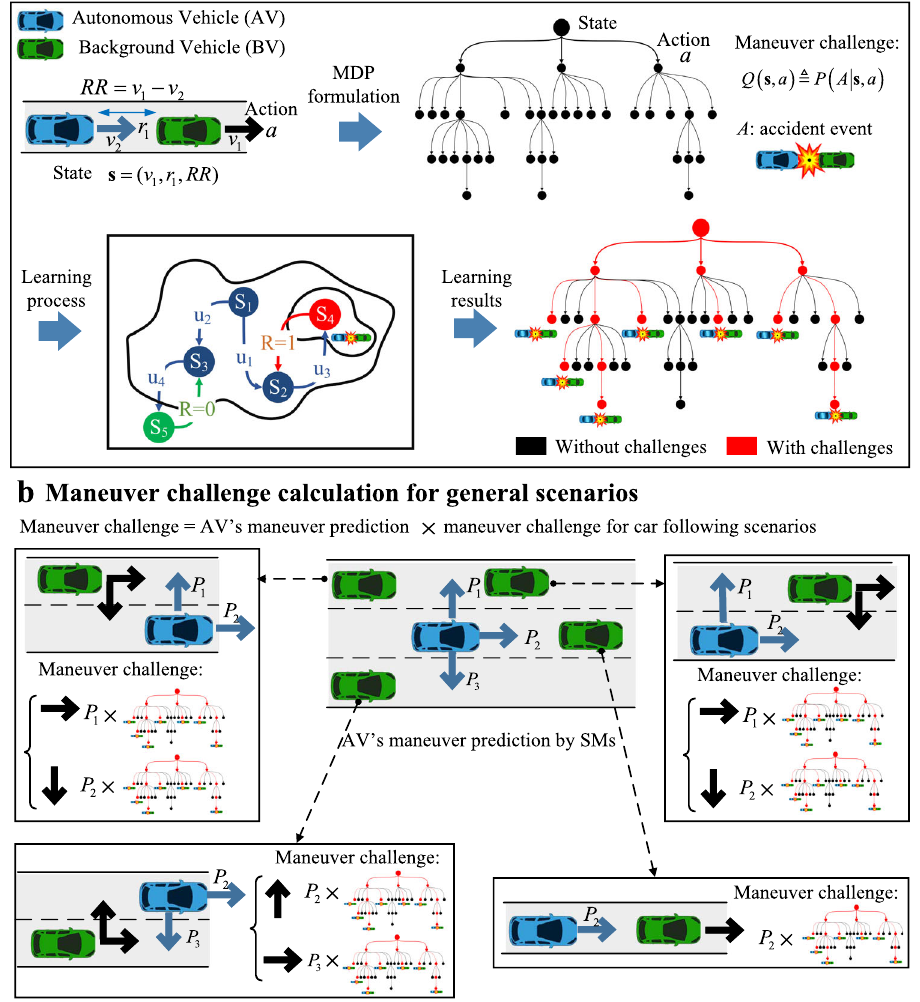
Fig. 4 Illustration of maneuver challenge calculation. a Maneuver challenge calculation of the BV ’ s accelerations for car following scenarios based on reinforcement learning techniques. The car following scenarios are formulated based on the Markov decision process (MDP), and the maneuver challenge values are calculated by the learning process. b Example of maneuver challenge calculation for general scenarios based on autonomous vehicle (AV) ’ s maneuver prediction by surrogate models (SMs) and results of car-following scenarios. The image of vehicles is previously published at